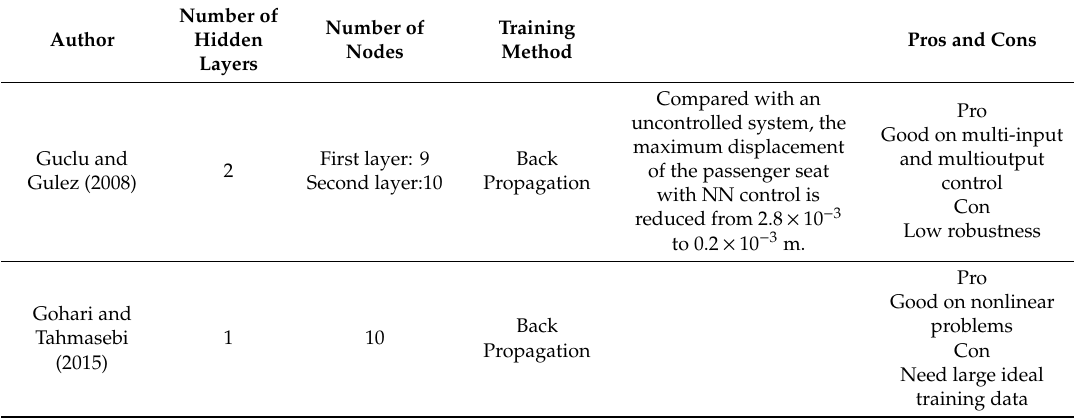
Table 3. Summary of ANN